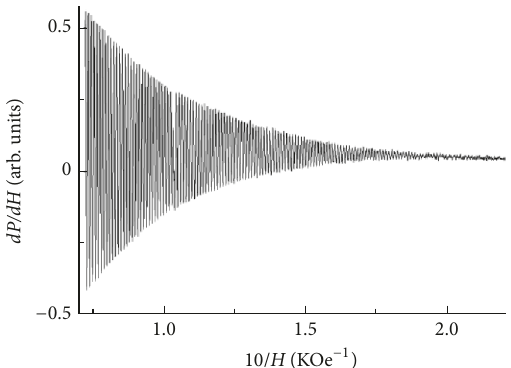
Figure 5: Shubnikov-de Haas oscillations in samples HgSe at T = 2.7 K [10].